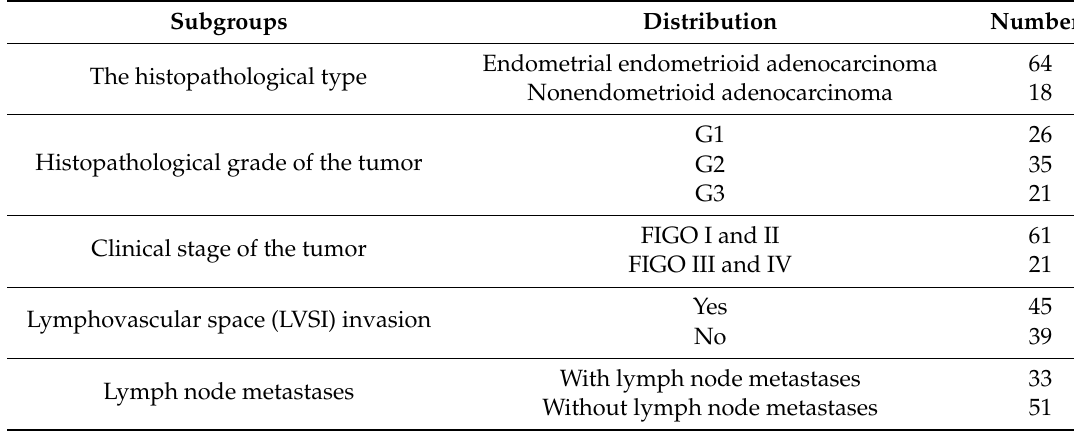
Table 2. Patients with endometrial cancer divided into